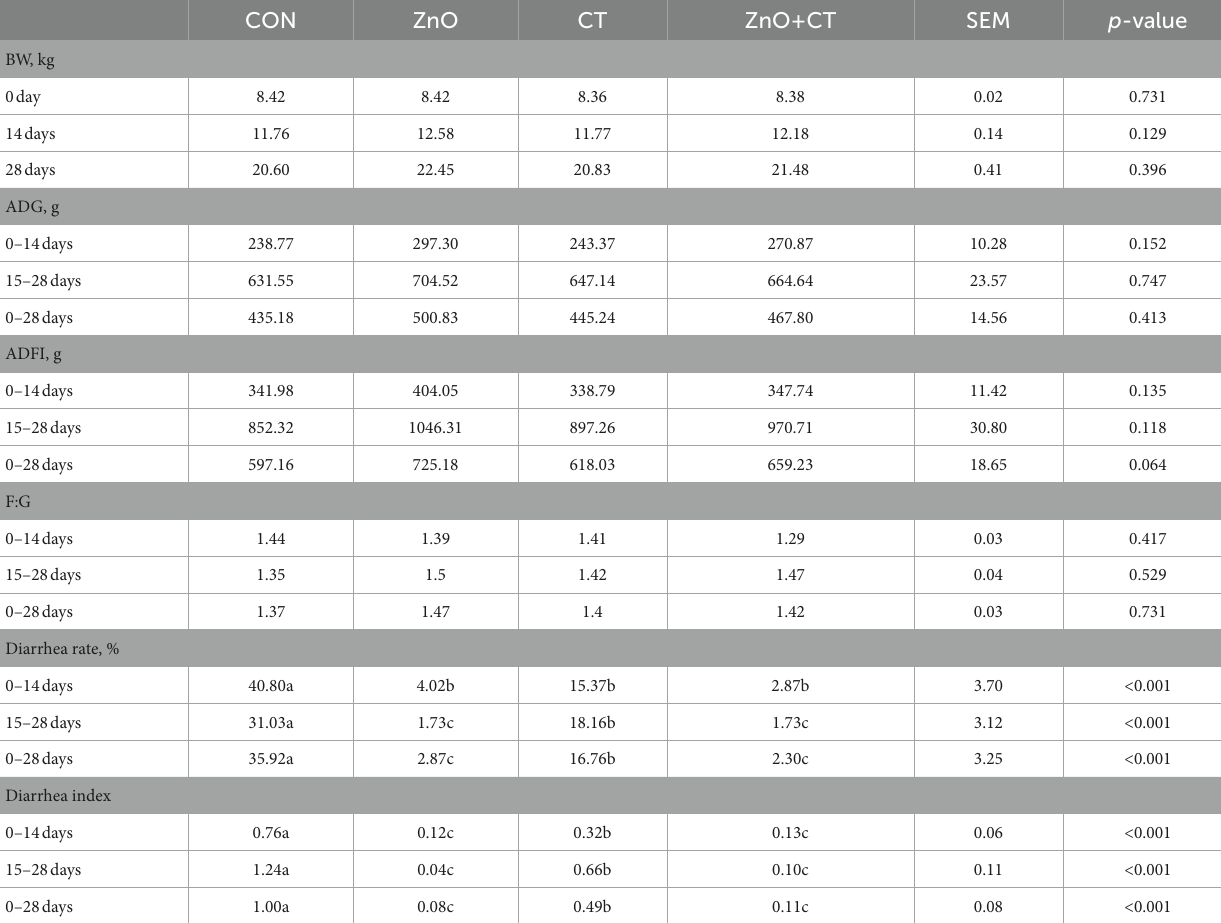
TABLE 1 Effects of ZnO and CT on growth performance of weaned piglets in K88-challenged environment. CON ZnO CT ZnO + CT SEM p